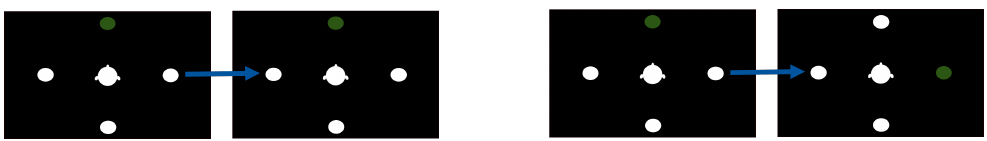
Figure 3. Transition of the target position between trials causing a switch of the auditory attention. Left: Repetition of the target position between trials. Right: Switching of the target position from front to right between trials.